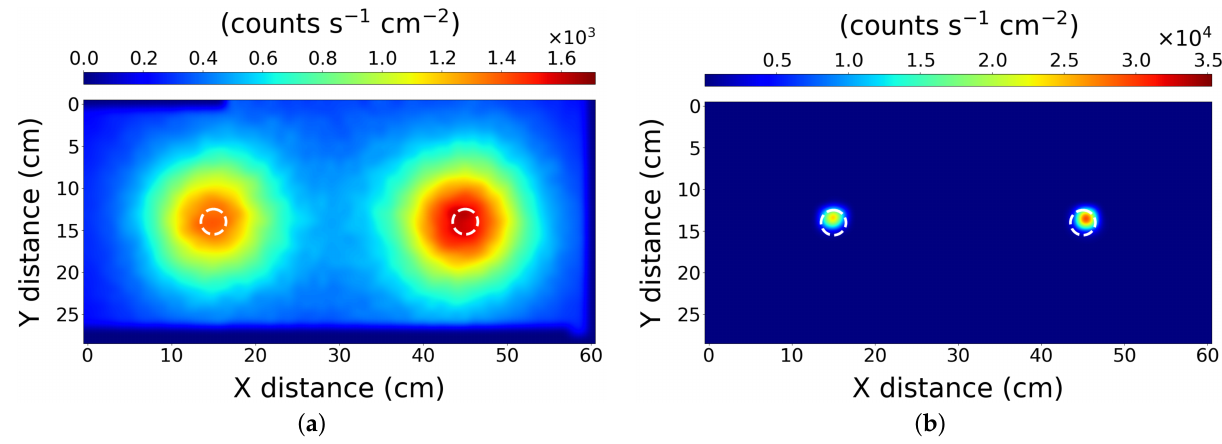
Figure 3. The results from scenario 1—Two similar sources. After processing with ( a ) simple interpolation, and ( b ) the PLR algorithm. The scan used a 1 cm resolution. The dashed white circles represent the true location of the source pucks.